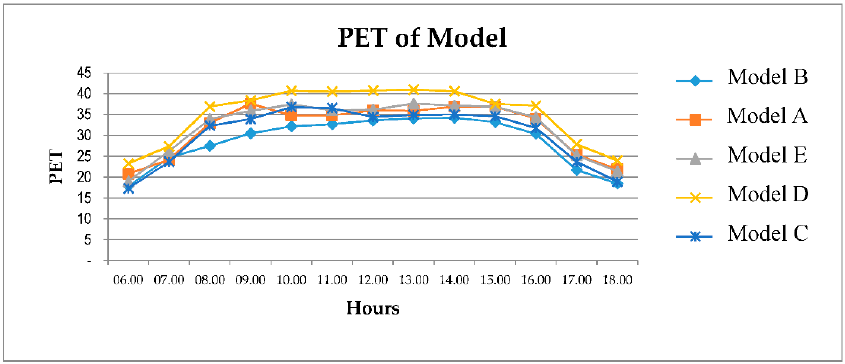
Figure 9. PET of Five Model. Generated by RayMan 1.2.